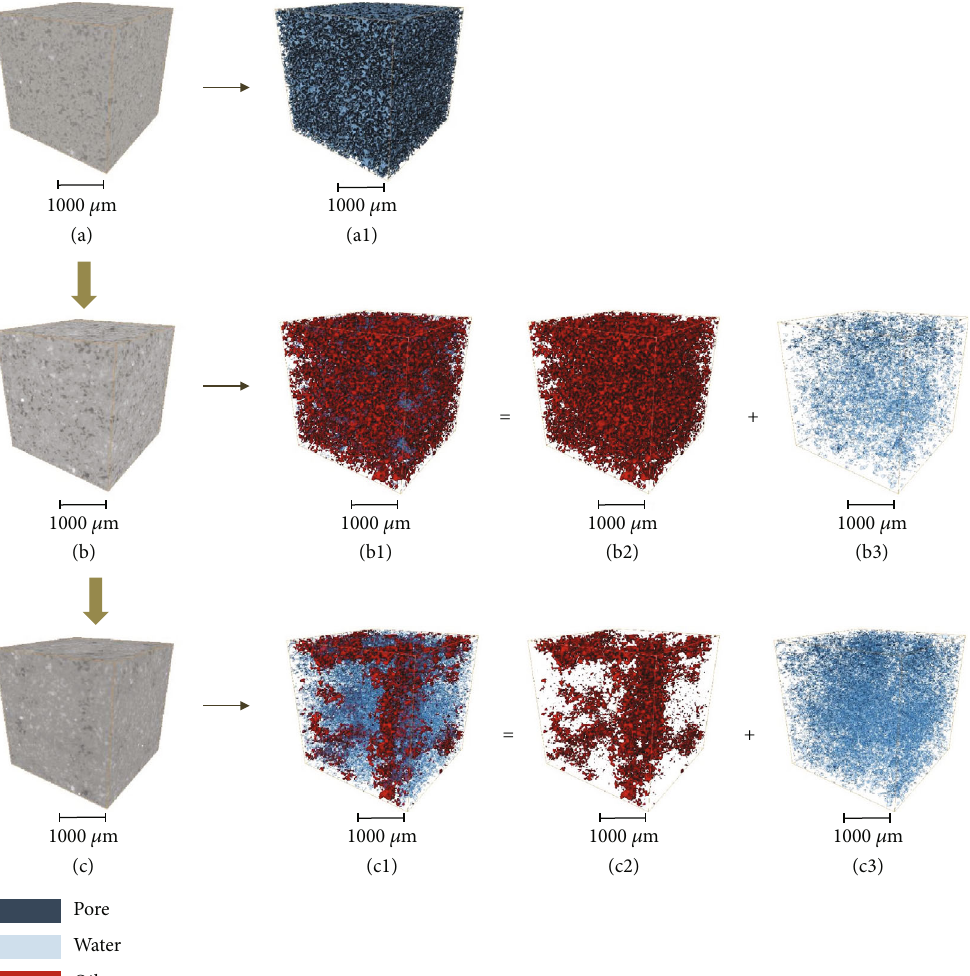
Figure 2: The core, oil, and water volume in di ff erent situations: (a) dry situation, (b) saturated oil situation, and (c) residual oil situation.